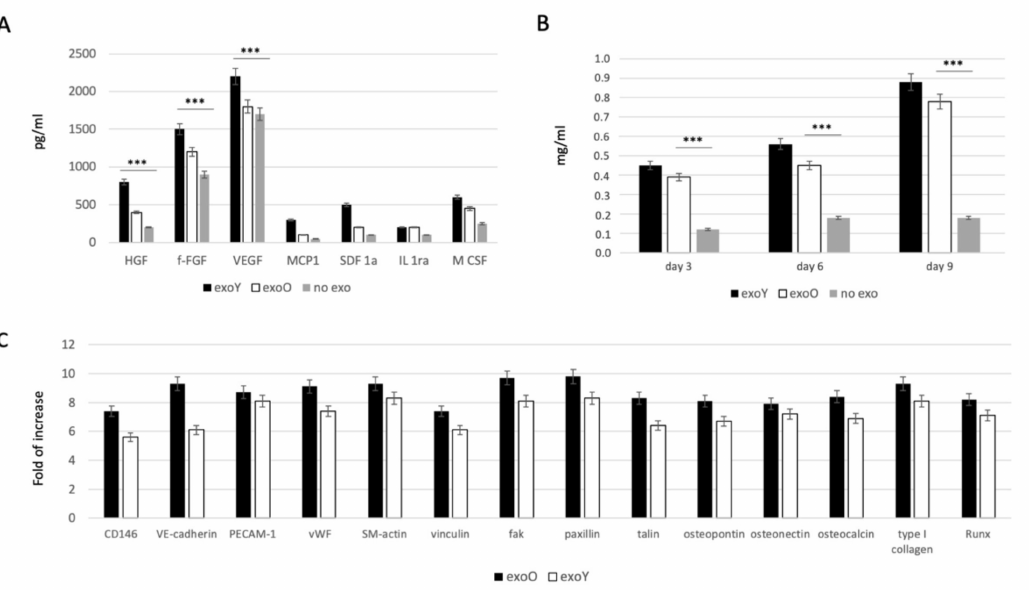
Figure 4. Evaluation of EXO influence on MSCs: ( A ) specifics growth factors quantification from MSCs after treatment with exoY and exoO compared to control (no exo). ( B ) ALP assay of MSCs under treatment with exoY, exoO compared to control (no exo). ( C ) qPCR of angiogenic and osteogenic factors from MSCs after treatment with exoY and exoO. *** p <